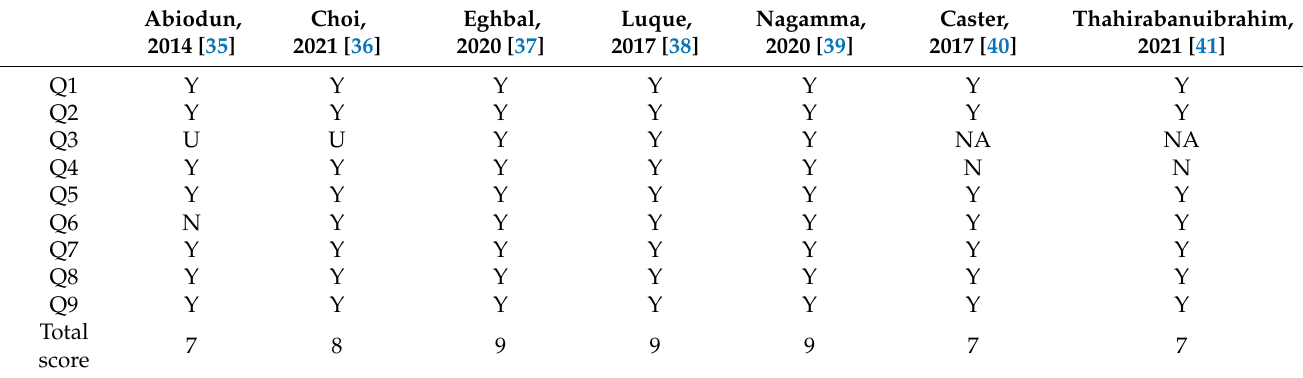
Table 2. Quality appraisal of the quasi-experimental